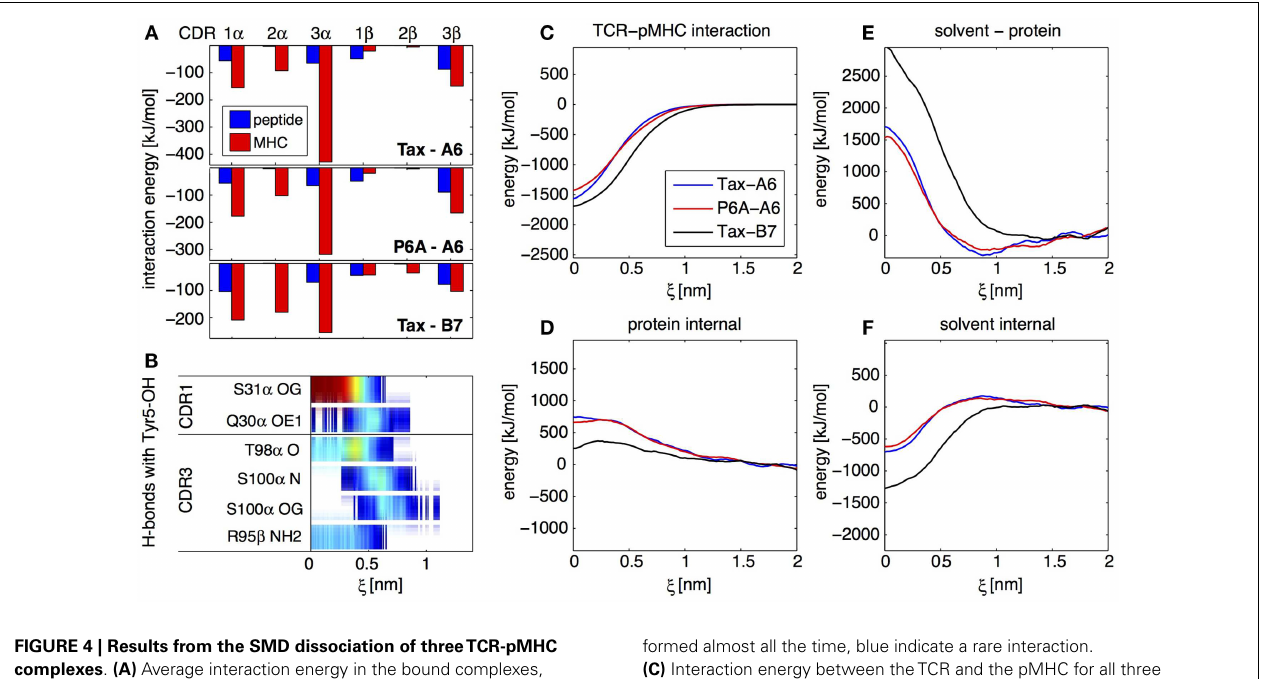
FIGURE 4 | Results from the SMD dissociation of threeTCR-pMHC complexes . (A) Average interaction energy in the bound complexes, partitioned in CDR and peptide/MHC contributions. (B) Focus on the OH group on the side-chain of the peptideTyr 5 residue.The color bars indicate the average occurrence of H-bonds withTCR atoms as a function of center of mass separation ξ . Red means that the H-bond is